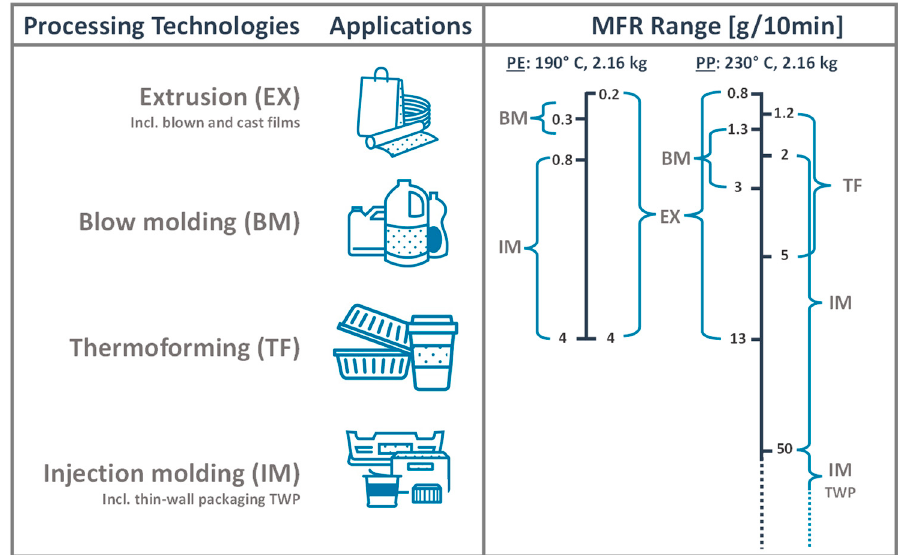
Figure 1. Illustration of the correlation between the MFR values of certain PO grades from packaging applications and the suitable processing technologies. Compiled based on several product data and information sheets from Borealis AG [18–21] (own illustration).